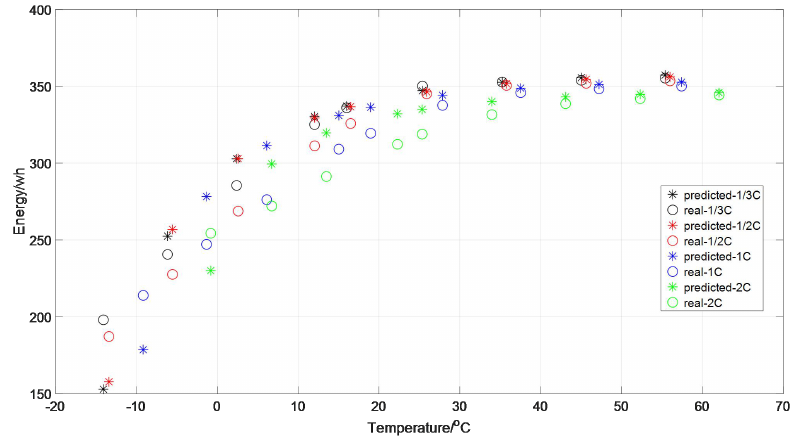
Figure 12. Prediction of output energy.